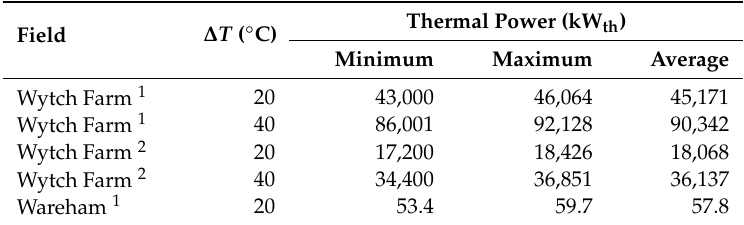
Table 4. Estimated thermal